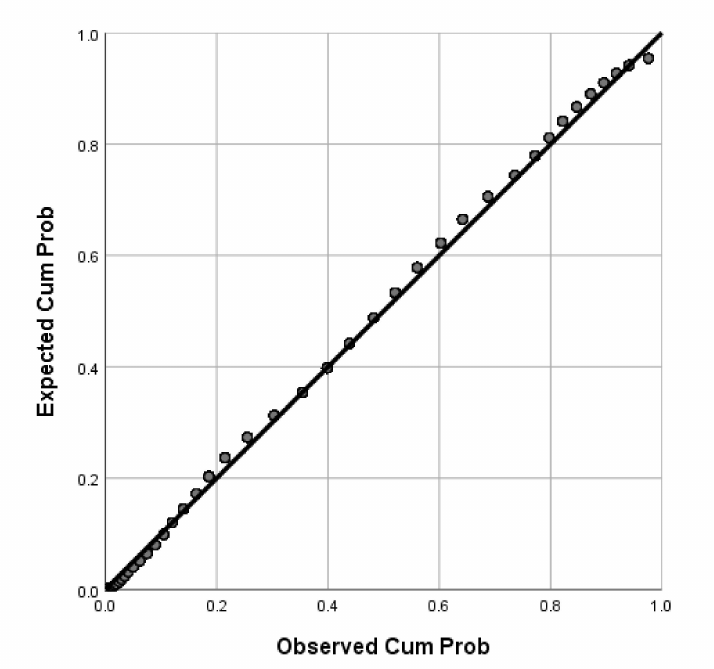
Figure 3. P-P plot of BAS-2 score.